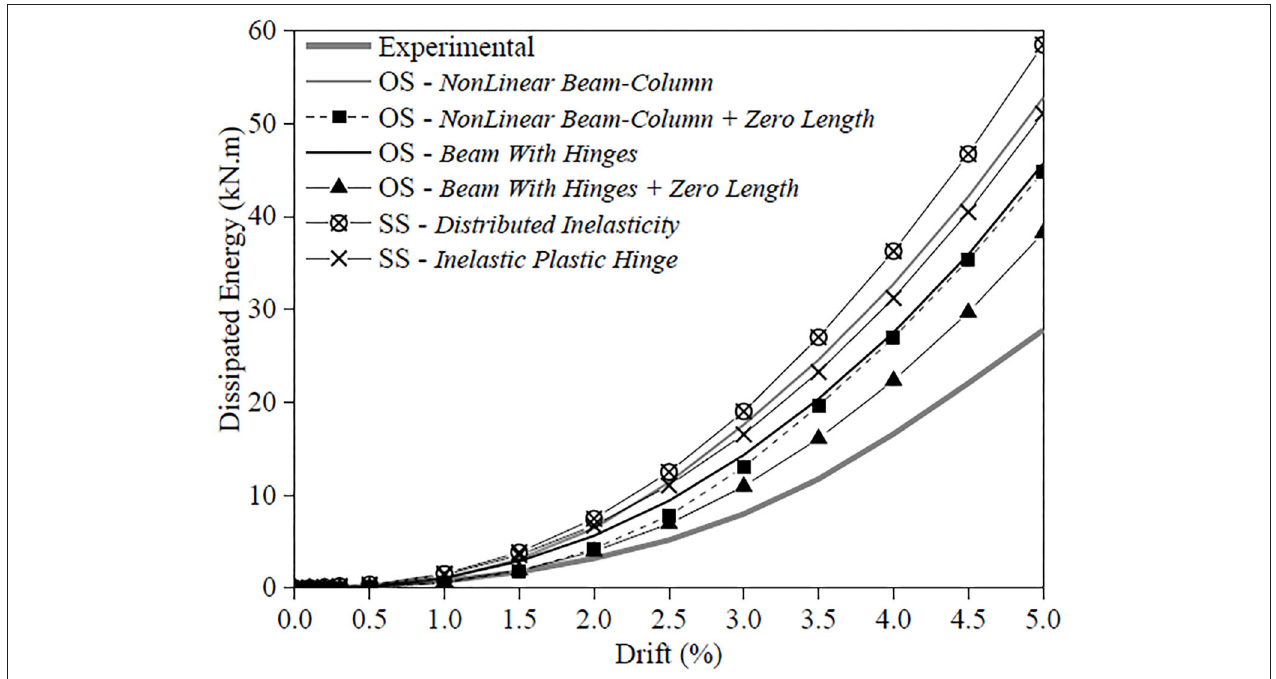
FIGURE 4 | Numerical and experimental dissipated energy evolutions of specimen CPA-3.